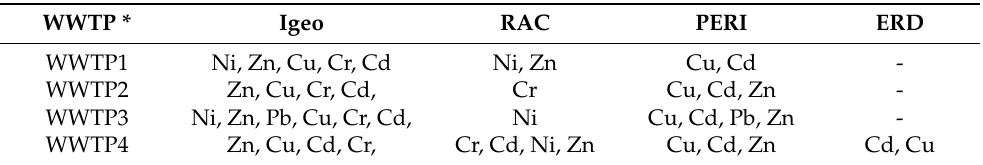
Table 8. Schedule of failure to meet heavy metal toxicity criterion from analyzed sites for four pollutant indicators.